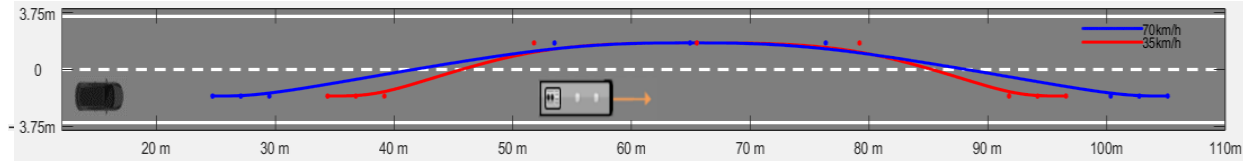
Figure 8. The vehicle has a constant speed of 35 km/h and 70 km/h to avoid large low-speed obsta- cles.